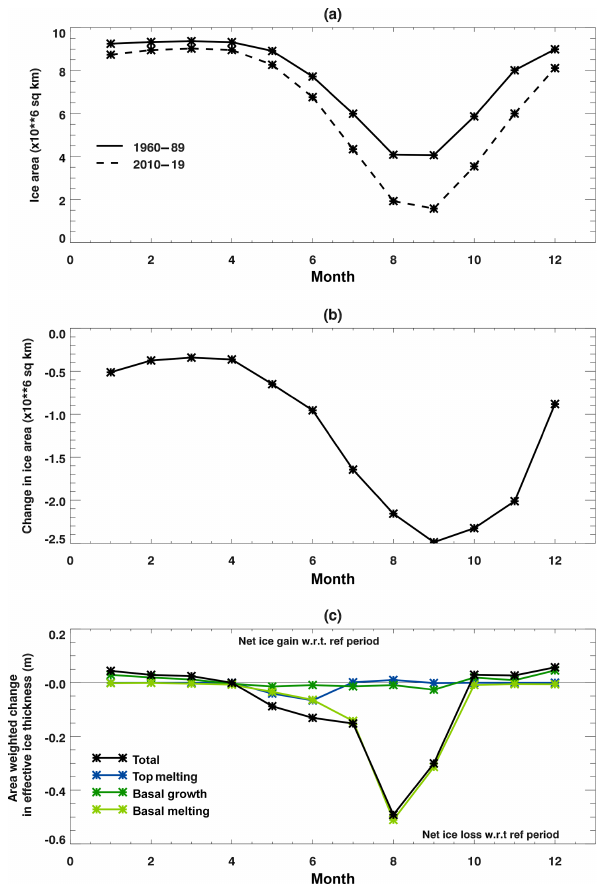
Figure 7. (a) Ice area over the domain defined in Fig. 2 during the reference period 1960–1989 (solid lines) and 2010–2019 (broken lines) for the HadGEM2-ES Hist1 + RCP8.5 scenario. (b) Change in ice area between 1960–1989 and 2010–2019. (c) Seasonal cy- cles of changes in selected sea ice volume budget components for 2010–2019 with respect to the reference period 1960–1989 for the HadGEM2-ES Hist1 + RCP8.5 integration. The components are de- fined in Sect. 3.1. Values are averaged over the region defined in Fig. 2 and weighted by the ice area in each case, so that the change is per unit area of the remaining